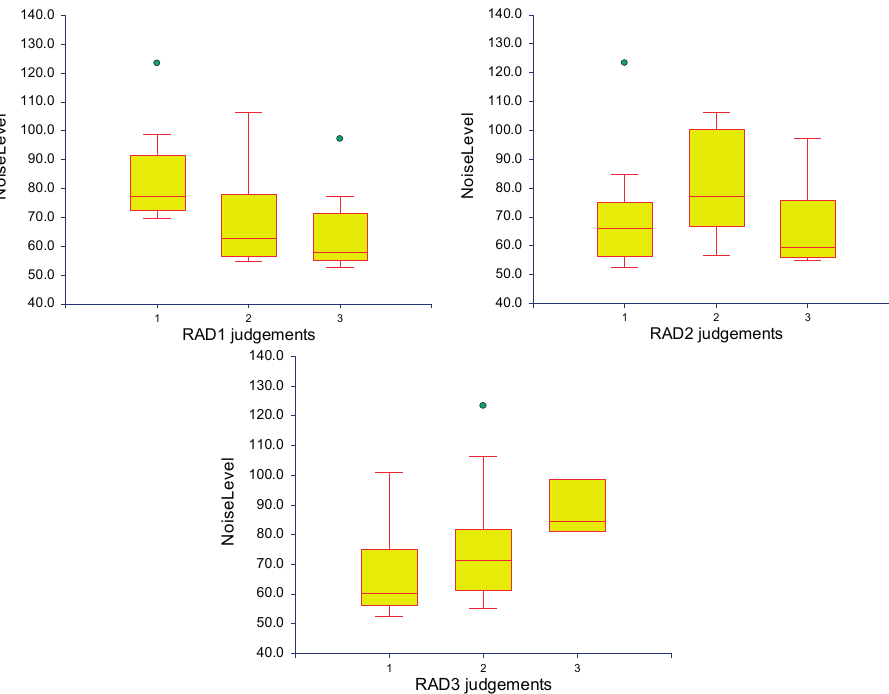
Figure 5. Box plots demonstrate the radiologist’s evaluation of the image quality using a 3-point scale. The red line within the yellow box indicates the median of the values. The red line at the bottom of the box corresponds to the 25th percentile, and the one at the top is the 75th percentile. The range between these two lines ( i.e. , the length of the box) is the inter Quartile Range (IQR). The lower cross line is 1.5 IQR below the 25th percentile, the upper cross line is 1.5 IQR above the 75th percentile. Individual observations